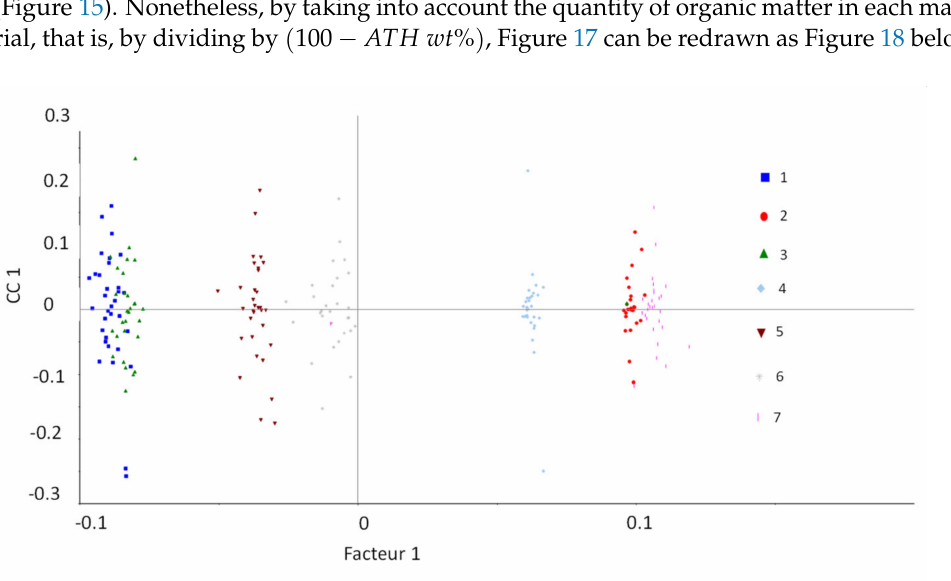
Figure 18. CC scores as a function of the polymers model type. Compared from Figure 17, radiation chemical yields have been normalised by the organic content in the polymer before being analysed. In this analysis, 1: Mod1, 2: Mod2, 3: Mod3, 4: Mod4, 5: Mod5, 6: Mod6, and 7: Mod